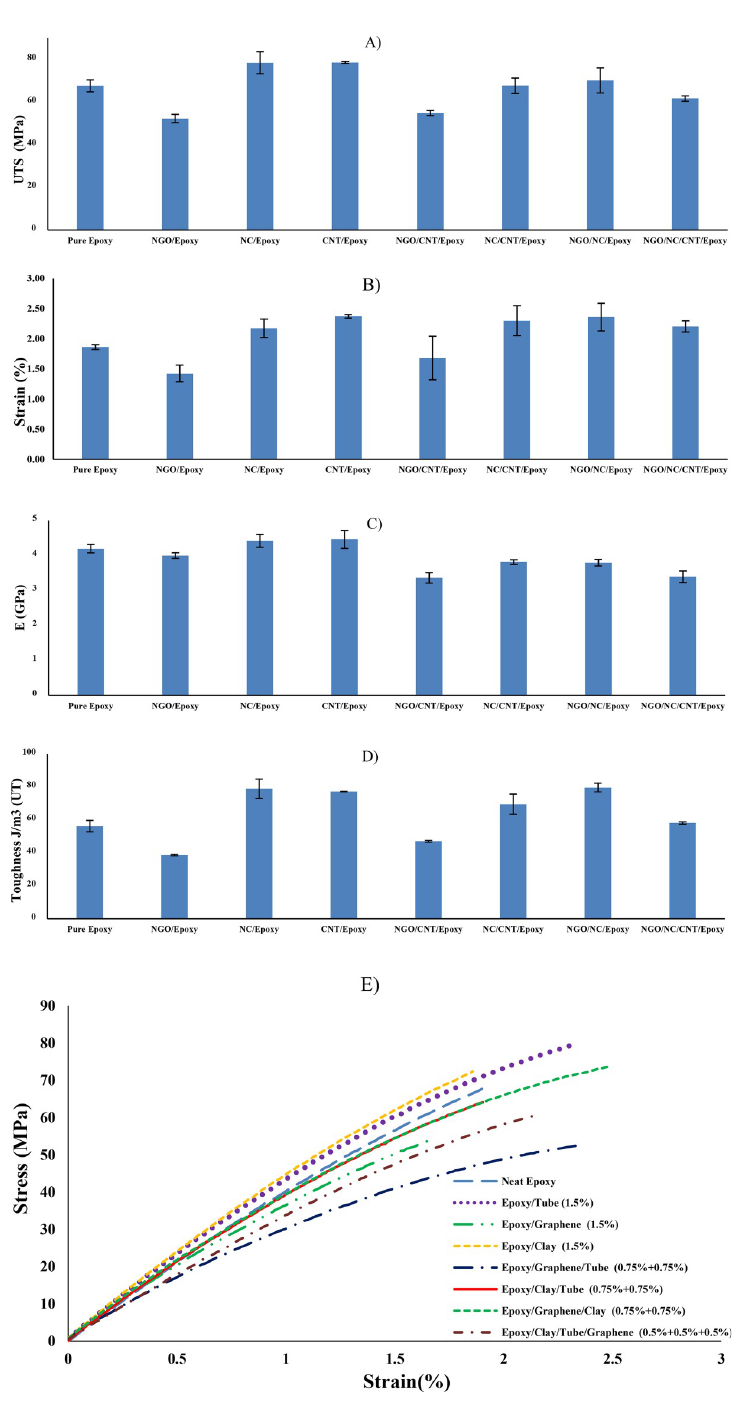
Fig 1. Pure epoxy and polymer matrix nanocomposites A) Ultimate Tensile Strength, B) Strain, C) Young modulus, D) Toughness, and E) Tensile stress-strain